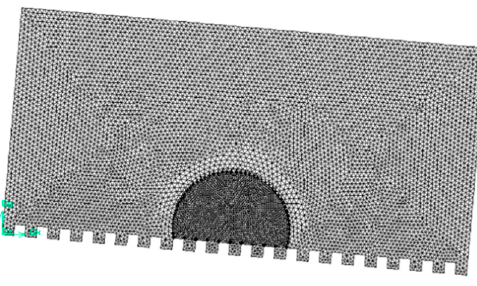
Figure 5. Model schematic diagram.